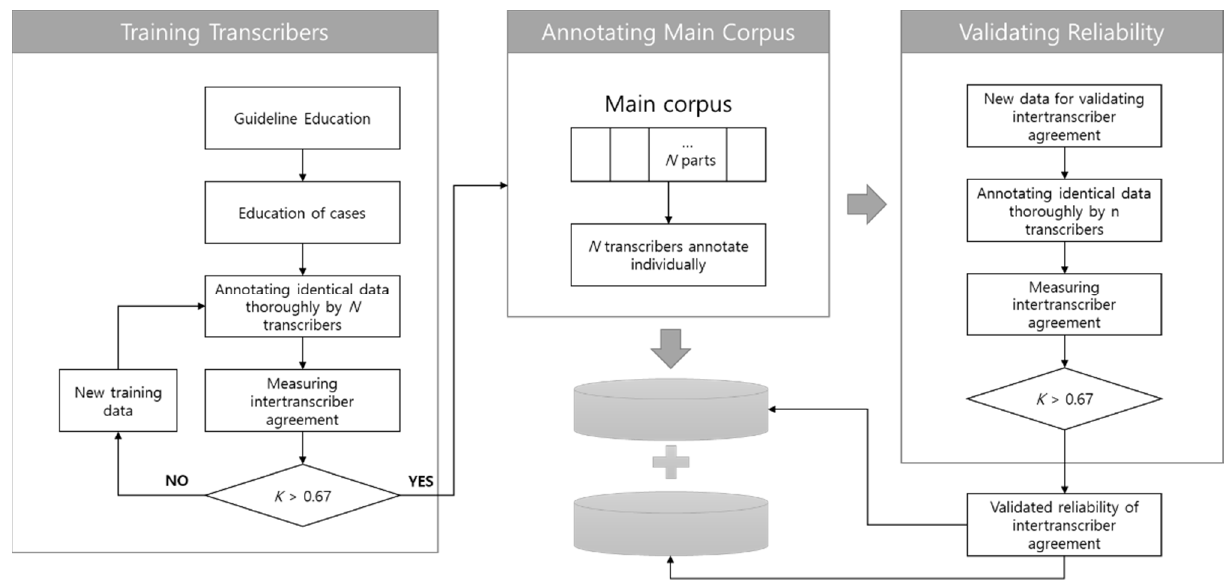
Figure 1. Confirming inter-transcriber reliability of prosodic breaks labeling.